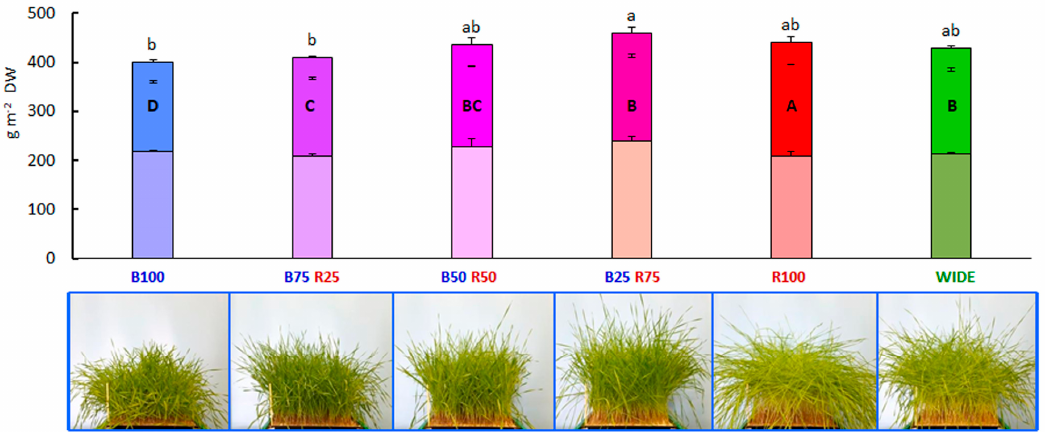
Figure 2. Upper histogram: whole plant biomass yield and biomass partitioning between shoots, (upper bars) and below-ground parts (bottom bars). Means followed by the same letters are not statistically different for p < 0.05 (Tukey’s HSD test)—small letters refer to significance for whole plant biomass, capital letters refer to significance of shoot biomass. Letters for below-ground biomass were omitted as the effect of treatments was not significant. Error bars represent +1 SEM for whole plant (top), shoot (middle), and below-ground (bottom) biomass. Lower pictures: side views of seedlings at Zadoks’ 12.